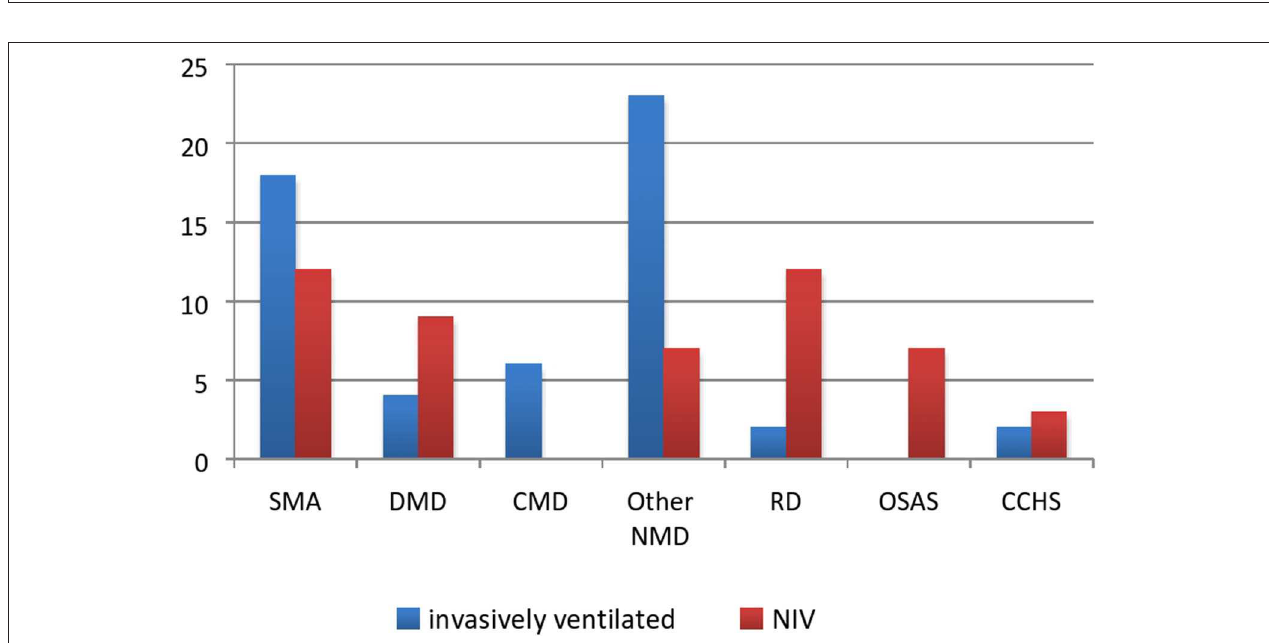
FIGURE 3 | HMV strategy in each group. SMA, spinal muscular dystrophy, DMD, Duchenne muscular dystrophy, CMD, congenital myotonic dystrophy; other NMD, other neuromuscular disease; PRD, primary respiratory disease; OSAS, obstructive sleep apnea syndrome; CCHS, congenital central hypoventilation syndrome.